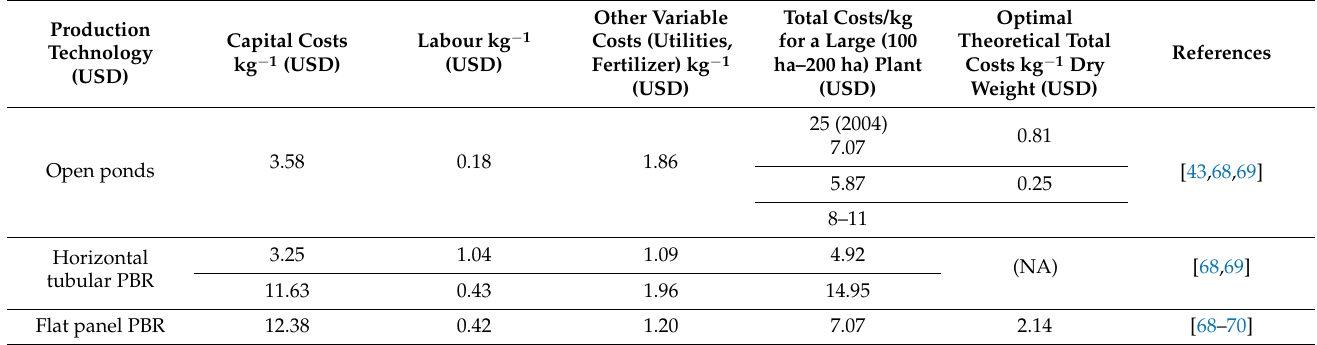
Table 5. Comparison of different methods of microalgae cultivation and cost of